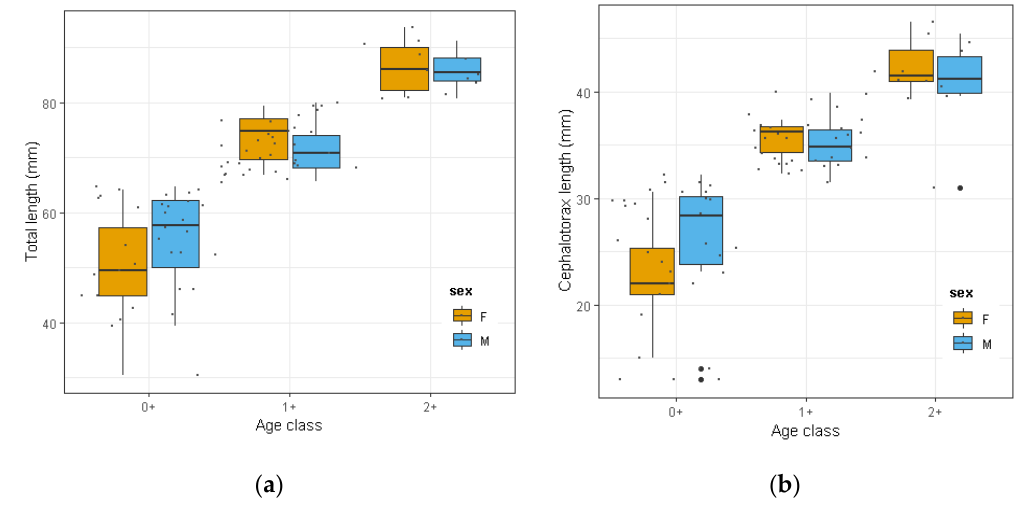
Figure 2. Boxplots showing variations in total body length ( a ) and cephalotorax length; ( b ) among age classes of Orconectes limosus in Lake Maggiore. Grey dots are observed values used to calculate each boxplot. A random noise (jitter) is applied to aid visualization of otherwise superimposed dots.